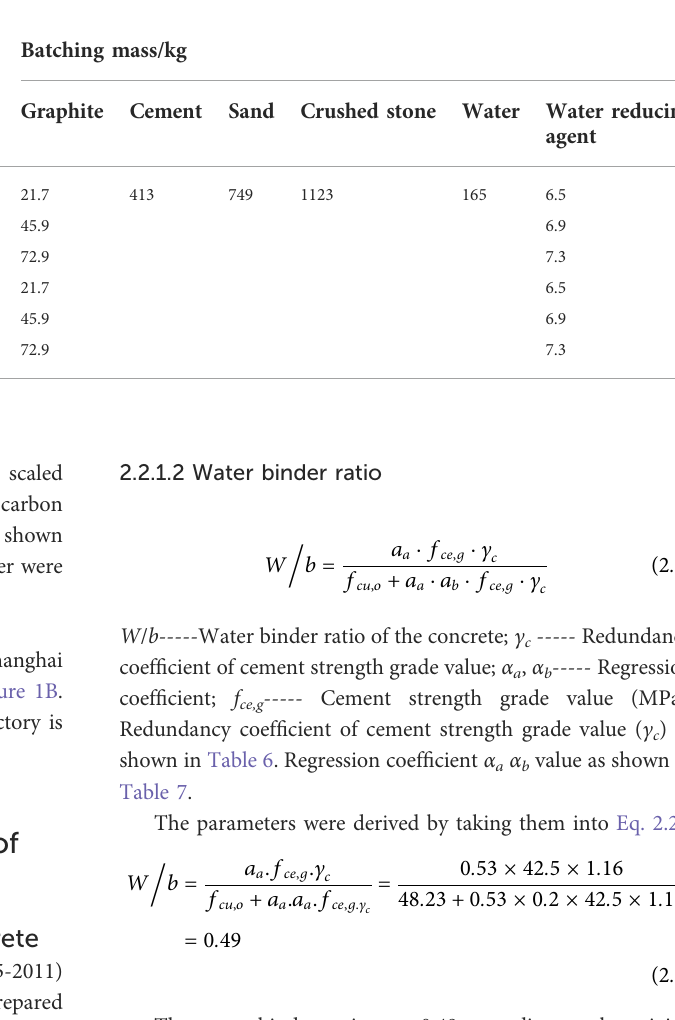
TABLE 12 Mix proportion of the